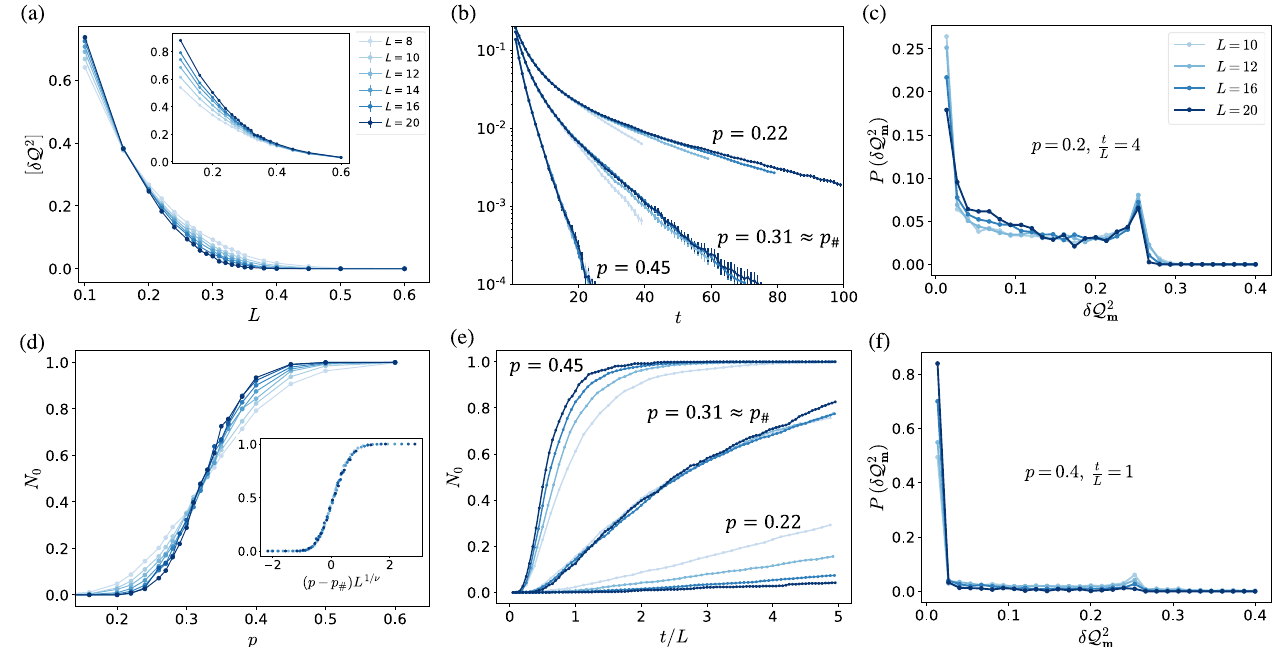
FIG. 8. Charge-sharpening transition in the statistical mechanics model. (a) Plot of ½ δ Q 2 (cid:2) versus p plotted for t=L ¼ 2 . We find that with increasing L the value of ½ δ Q 2 (cid:2) approaches zero for p > p # ≈ 0 . 3 . This is consistent with the entanglement transition in the qubit for p > p # . Inset: charge variance in half of the system. (b) Charge variance ½ δ Q 2 (cid:2) =L sector where we observed area-law scaling for h S n i versus time t . For p ≲ p # , ½ δ Q 2 (cid:2) =L decays exponentially with a decay rate decreasing with L . For p > p # , the decay rate is the same for all L suggesting that h σ 2 i =L goes to zero faster with increasing system size (faster in units of t=L ). (c) Histogram of the charge variance in the charge-fuzzy phase. (d) Plot of N 0 versus p with finite size collapse in the inset. N 0 was calculated at t=L ¼ 2 . We find excellent collapse for p # ¼ 0 . 315 and ν ¼ 1 . 3 . (e) Time evolution of N 0 . We clearly see a reversal in trend with system size L around p # ≈ 0 . 31 . At the transition p ¼ p # we find that N 0 ∼ h ð t=L Þ , with h ð x Þ some scaling function, consistent with a dynamical exponent z ¼ 1 . (f) Histogram of the charge variance in the charge-sharp phase. The peak at 0.25 is due to trajectories with superposition of two charge sectors Q and Q þ 1 . The peak is stronger, and more stable, in the fuzzy phase than in the sharp phase. Error bars in (a) and (b) are obtained from the error of the mean using standard